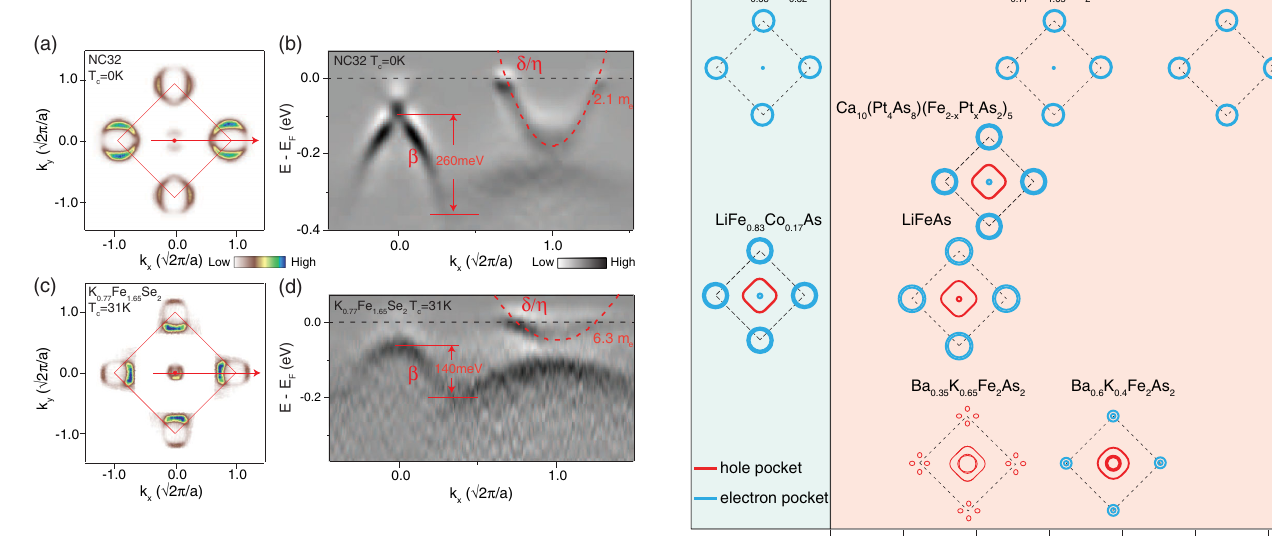
FIG. 7. (a) Photoemission intensity map across the Z point for NC32, taken with 100-eV photons in s polarization. (b) The photoemission intensity distribution along the Z - A direction as illustrated by the red arrow in panel (a) for NC32, taken with FIG. 8. Summary of the relation between Fermi-surface top- 100-eV photons in s polarization. (c) Photoemission intensity ology and T C for different compounds in FeHTS ’ s. All the Fermi map across the Z point for K 0 surfaces were taken across the Γ point. The hole pockets and Fe 1 Se 2 , taken with 31-eV . 77 . 65 electron pockets are illustrated with red and blue lines, respec- photons in mixed polarization. (d) The photoemission intensity tively. T C is not directly correlated with the Fermi-surface distribution along the Z - A direction for K 0 Fe 1 Se 2 , taken with . 77 . 65 121-eV photons in s polarization. Note that both 31-eV and topology. The Fermi surfaces of K 0 121-eV photons correspond to the Z point in the Brillouin zone FeSe = STO, and Ca 10 ð Pt 4 As 8 Þð Fe 2 − x Pt x As 2 Þ 5 were extracted for K 0 from Refs. [19,20,64], Fe 1 Se 2 . . 77 . 65